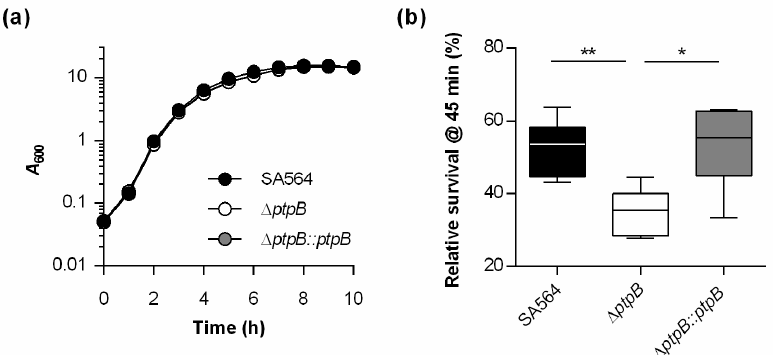
Figure 1. PtpB does not affect growth of S. aureus SA564 in TSB but promotes survival in macrophages. ( a ) Growth kinetics of S. aureus strains SA564 (black symbols), SA564 ∆ ptpB (white symbols), and SA564 Δ ptpB::ptpB (gray symbols) in TSB. Cells were cultured at 37 °C and 225 rpm at a culture to flask volume of 1:10. Data represent the mean A 600 readings ± SD at the time points indicated ( n = 3). ( b ) S. aureus short-term survival in infected macrophages. Survival rates are given in relationship to the intracellular bacterial cell numbers seen immediately after the gentamicin/lysostaphin treatment, which was set to 100%. The data are presented as box and whisker plot showing the interquartile range (25-75 %, box), the median (horizontal line) and the standard deviation (bars) of six independent experiments. * p < 0.05; ** p < 0.01 (Mann-Whitney U test).